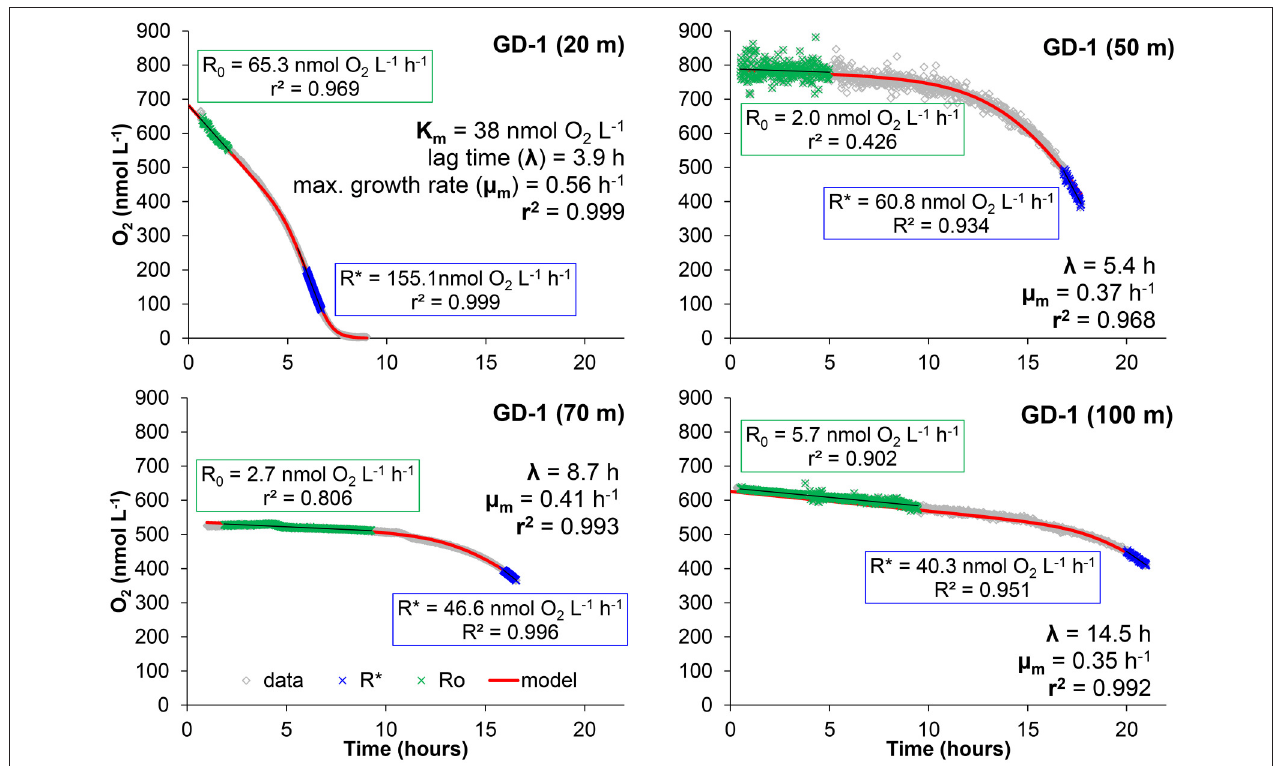
FIGURE 3 | Examples of the bottle effect measured in Golfo Dulce at different depths (19 of January 2015, Station GD-1). Data were modeled as described in the text in order to calculate: initial respiration rate ( R 0 ) and maximum respiration rate during the incubation ( R *), half saturation constant ( K m ), lag-phase ( λ ), and maximum growth rate ( µ m ) of the microbial activity in the bottles during the